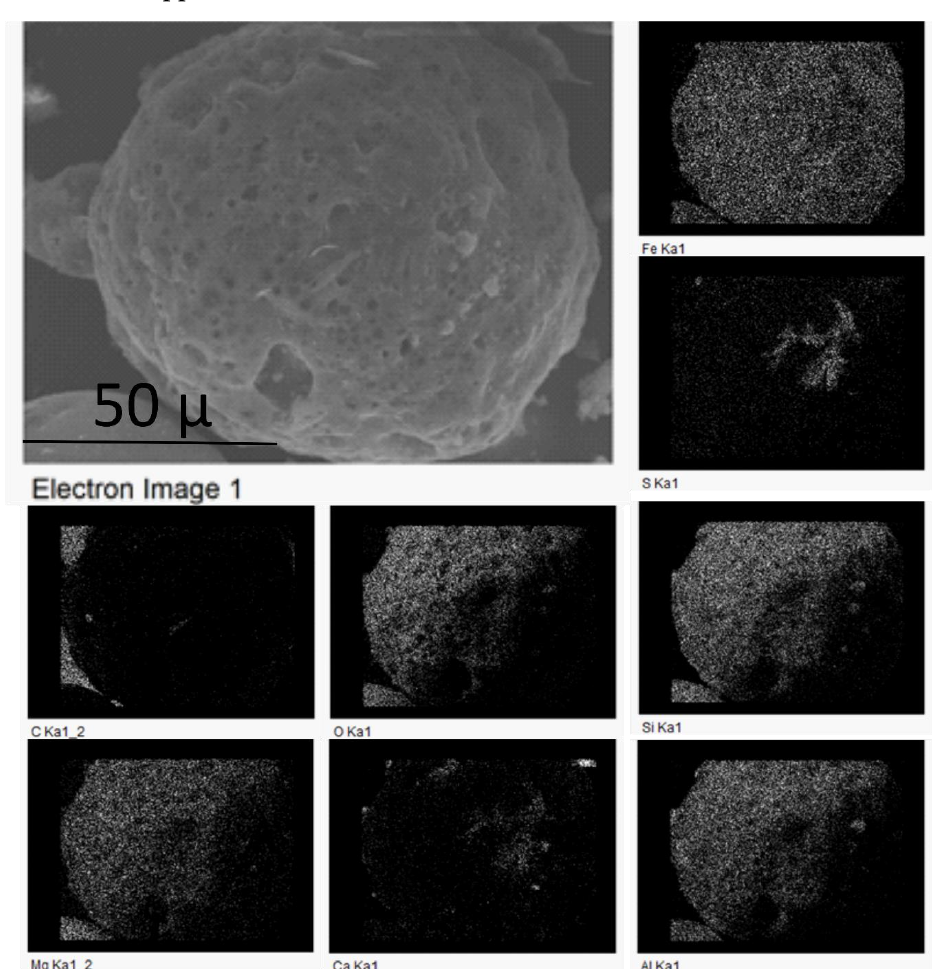
Figure A1. SEM-EDx analysis of a cenosphere from received fly ash. This cenosphere is mainly composed of Al, Fe, Si and Mg. The presence of anhydrite is also observed on this cenospheres as evidenced by the concurring presence of Ca and S, taking into account the composition and possible phases identified with XRD (Figure 1).